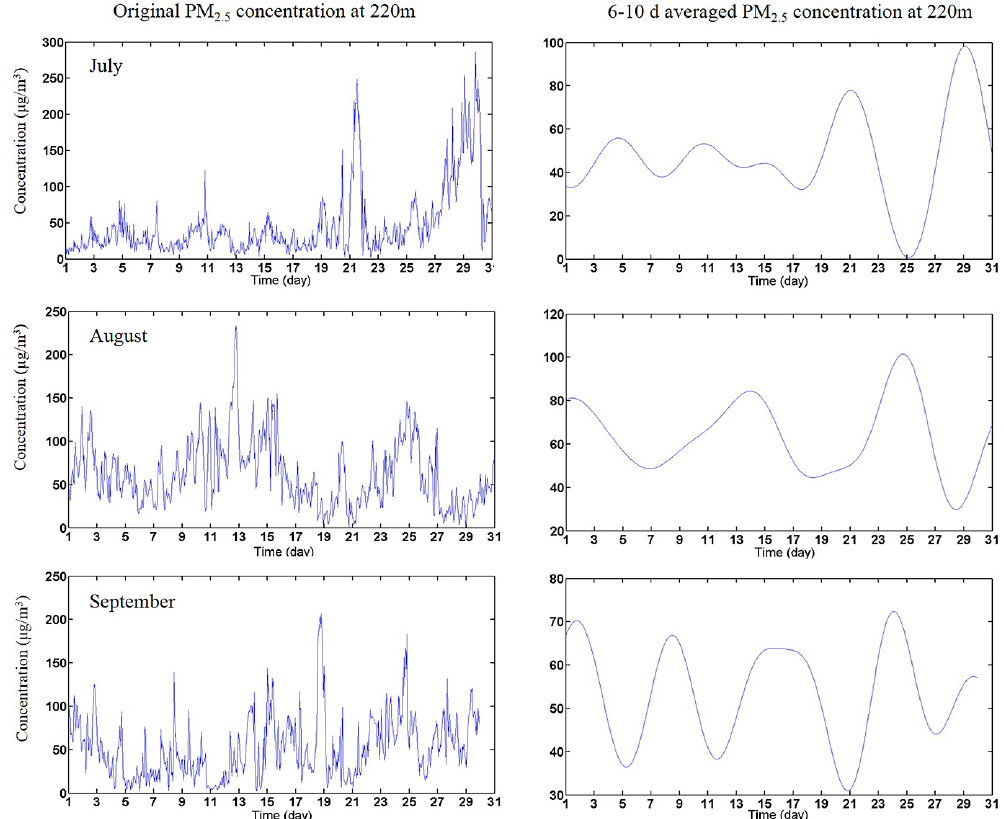
Figure 7. Time series of PM 2 . 5 hourly concentration before and after